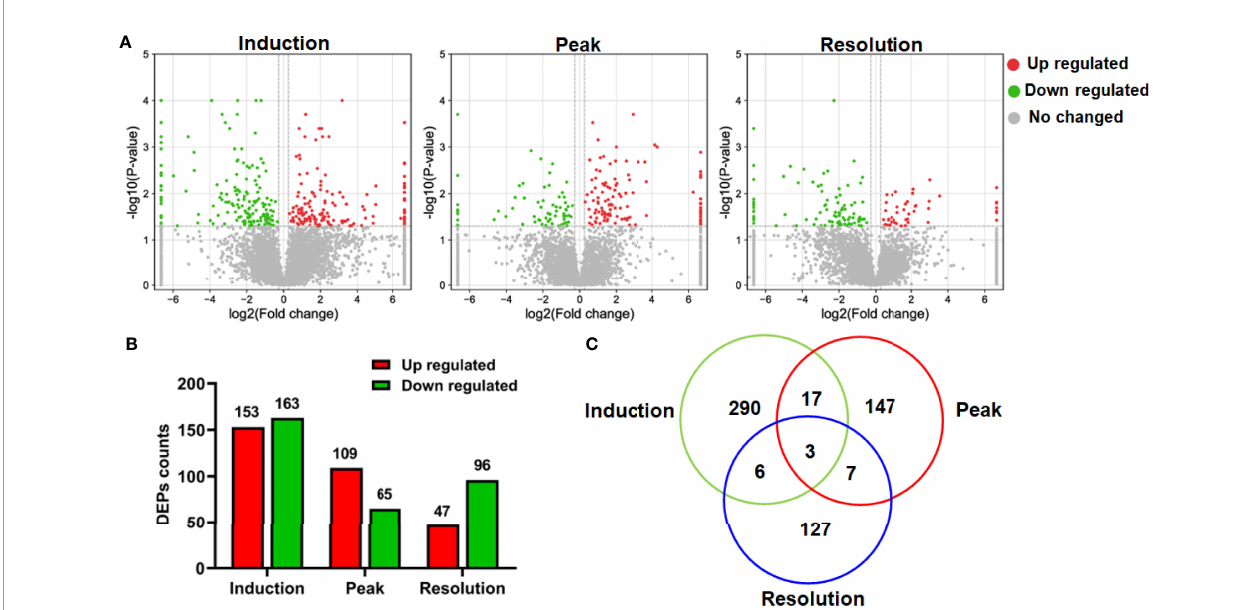
FIGURE 2 | The differentially expressed proteins (DEPs) in the proteomics data. (A) The volcano plot depicted the DEPs at different phases. (B) The number of upregulated and downregulated DEPs at different phases. (C) The Venn diagram showed protein identi fi cation overlap at different